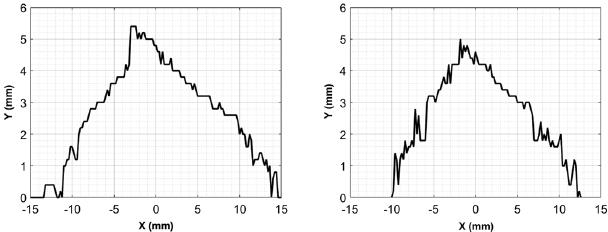
FIG. 16. Transverse dynamic aperture without (left) and with (right) synchrotron oscillations.